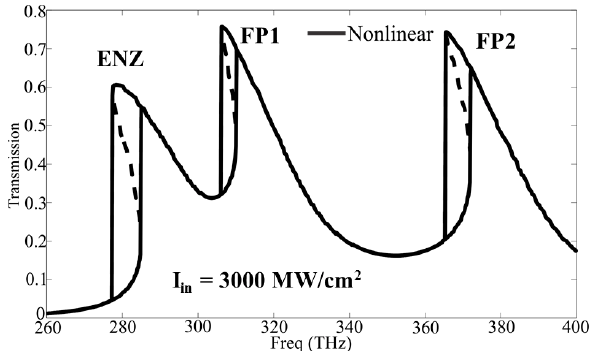
Figure 5: Transmission coefficient versus frequency for the slab nonlinear operation. A strongest hysteresis and bistable response is clearly obtained at the ENZ